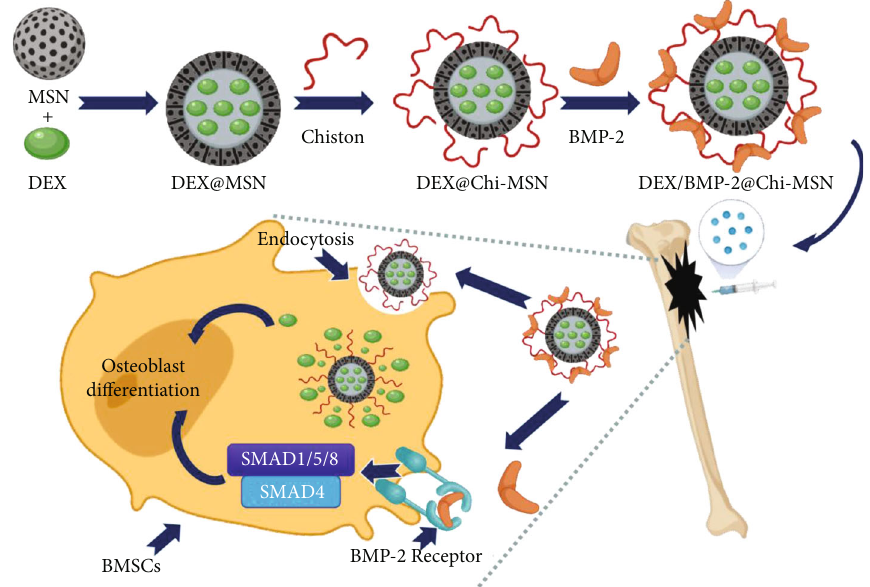
Figure 1: Schematic diagram of assembly process and mechanism of